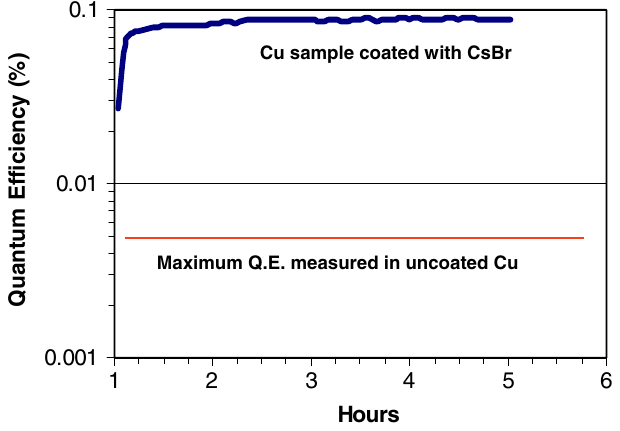
FIG. 4. (Color) Results of quantum efficiency (%) obtained with a copper target coated with an 18 nm thick CsBr film. The sample was exposed to air for 1 min and baked at 140 C over- night before the data was taken. The data shown was obtained at 4 (cid:4) 105 W = cm 2 with a 257 nm laser, an accelerating voltage of 1200 V, and a chamber pressure of 5 : 6 (cid:4) 10 (cid:1) 10 Torr . The maximum Q.E. for the uncoated Cu sample presented in Fig. 1 after surface cleaning by UV exposure at 257 nm is also shown for